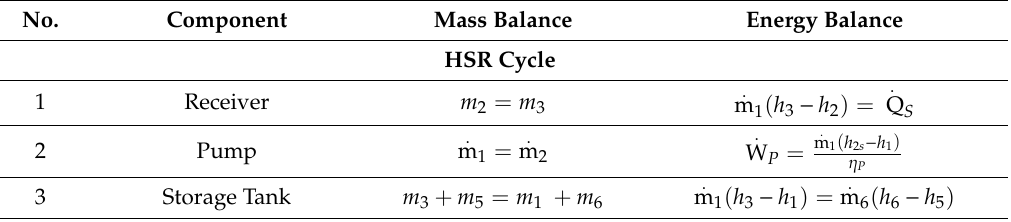
Table 3. Equations of mass and energy balances for the HSR cycle